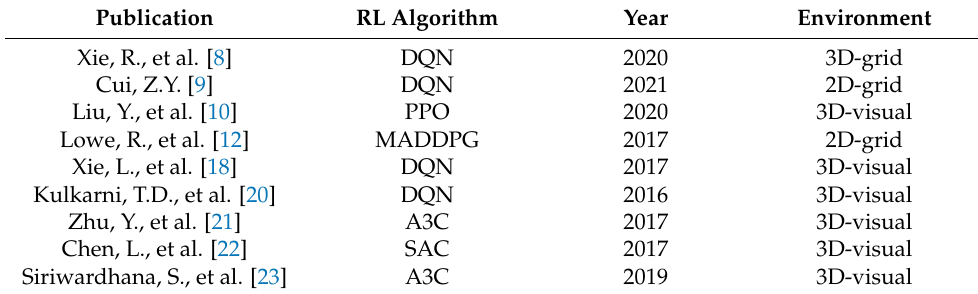
Table 1. Existing surveys related to the study of UAV path